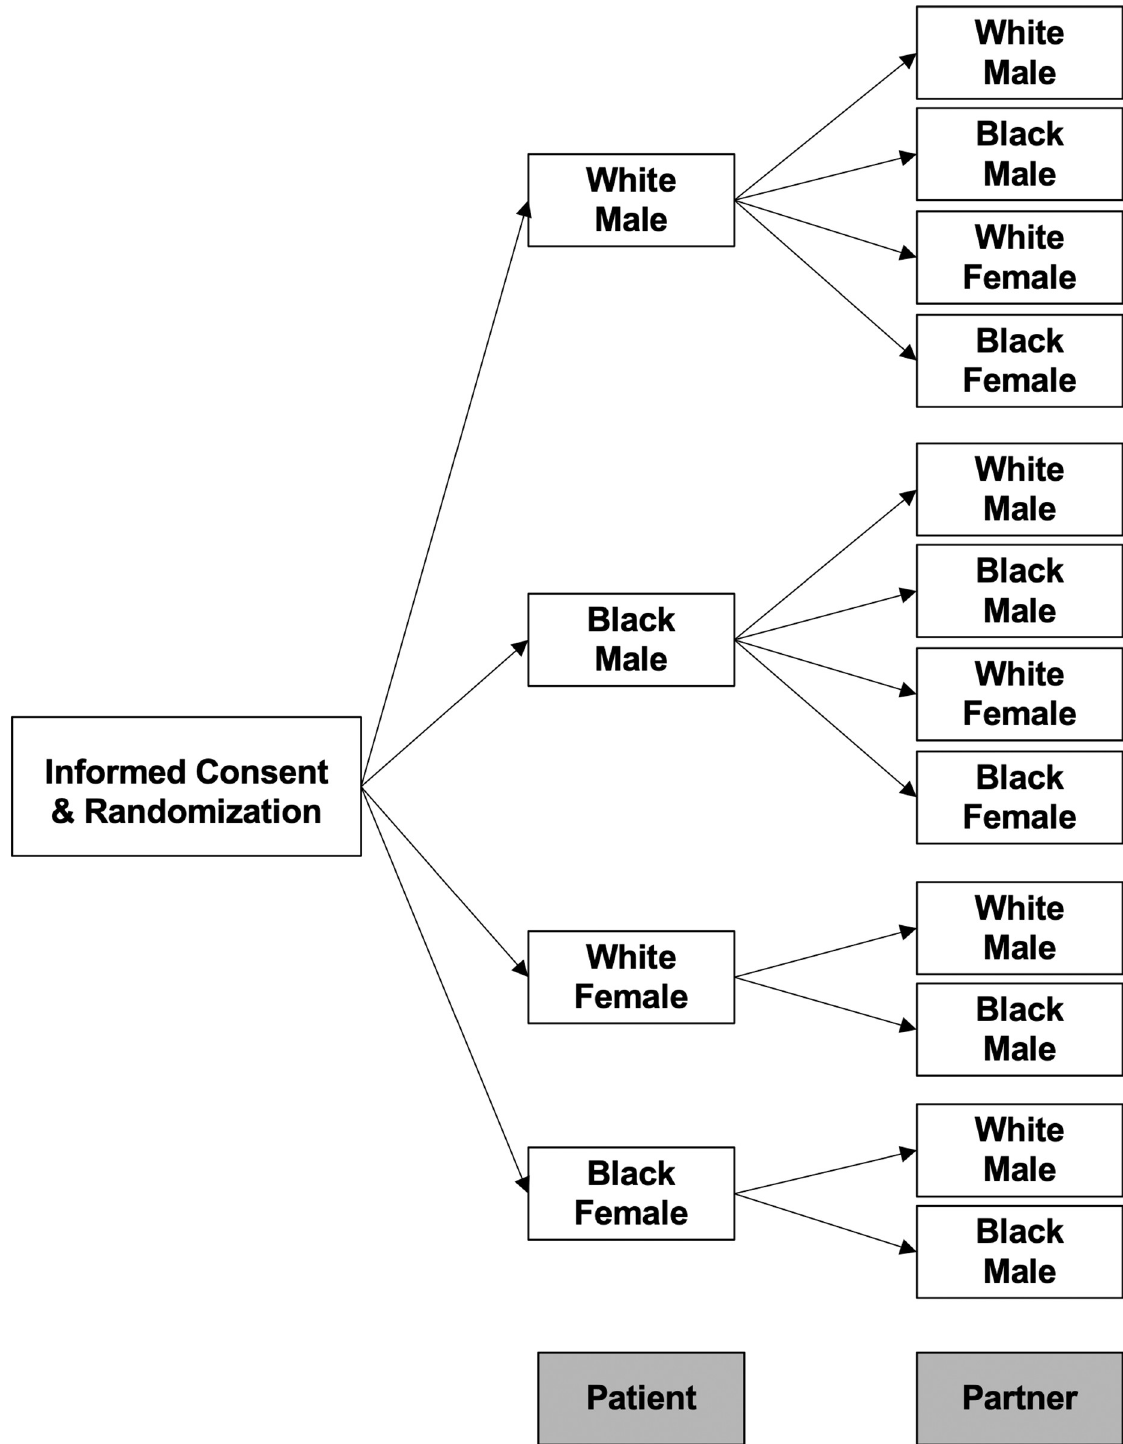
Fig 1. Organization of the study including the randomization process and the organization of the 12 individual study conditions. Following completion of the informed consent, participants were randomized to one of the patient couple presentations, which were comprised of the combinations